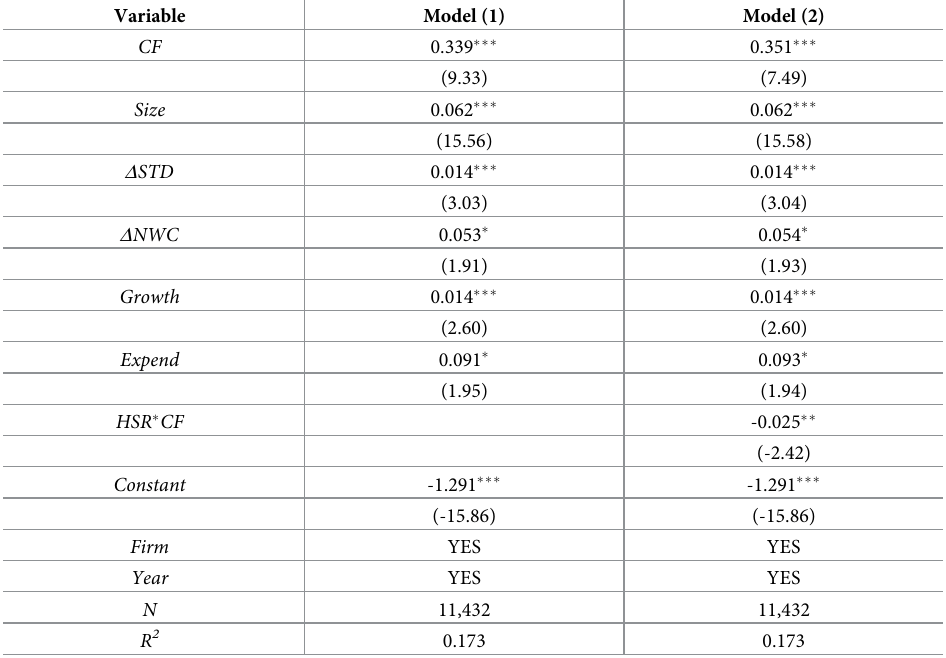
Table 10. Regression results of cash-cash flow sensitivity